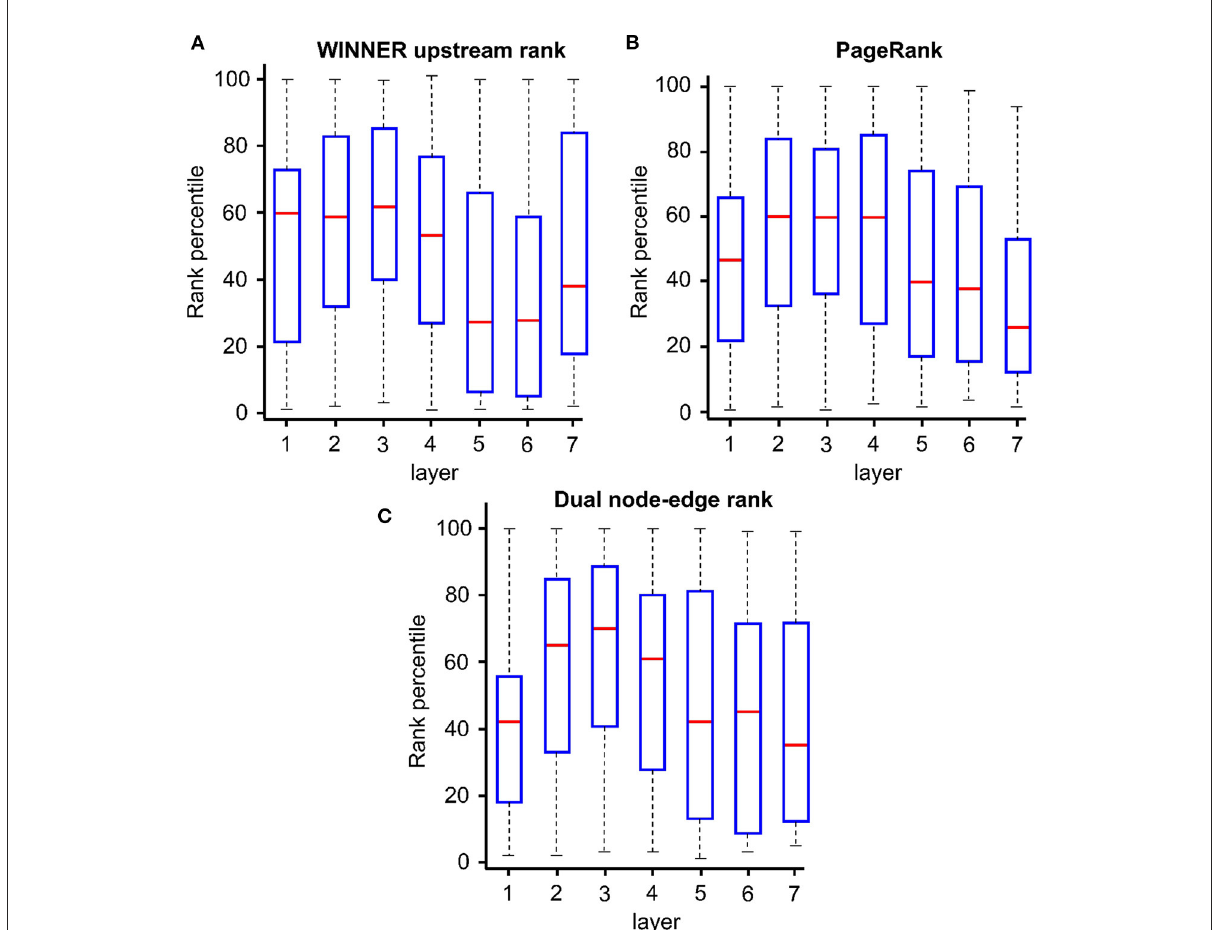
FIGURE5 WINNER upstream prioritization more accurately identifies the relative position of genes in a pathway. Gene-gene regulatory relationships from STRING v.10.5 were used to distribute genes from all KEGG cancer pathways into 7 layers via WINNER (customized for upstream ranking), PageRank, and Dual Rank; genes coding for proteins that function further upstream in the pathways were assigned to the lower-numbered layers. Layers 1–3 are the most upstream layers, usually correspond to the kineases, grow factors, and receptors. Layers 4–7 are downstream, usually correspond to signaling hubs, phospholization, transcription factors, and inside-nucleus genes. The y axis indicates the ranking scores, which were converted into percentile so that the rankings across different pathways could be combined into one boxplot. The red cross implies boxplot outliners (beyond 2 and 98% percentiles). (A) WINNER upstream rank. (B) PageRank. (C) Dual node-edge